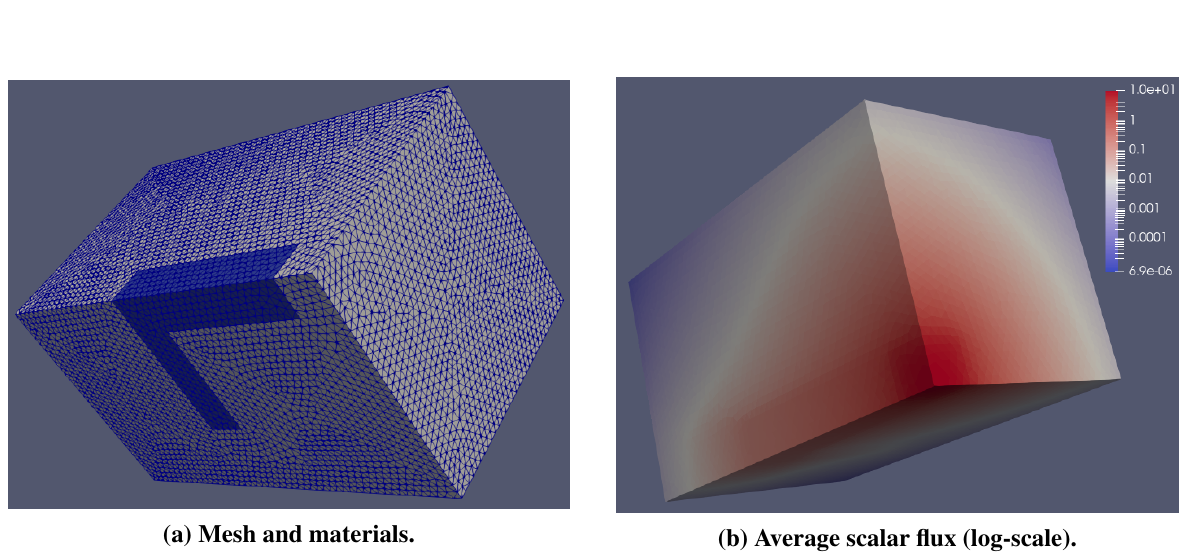
Figure 2: Mesh and solution for Case 3ii with linear